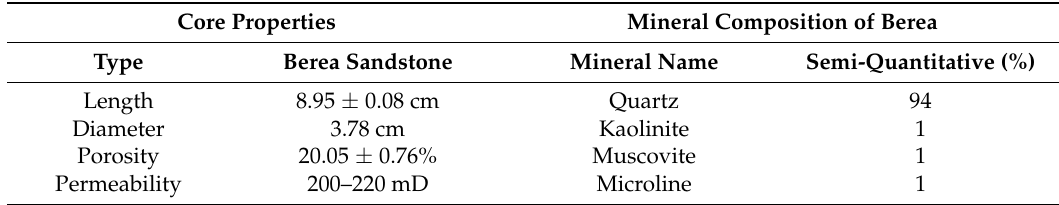
Table 1. Properties and mineral composition of used Berea